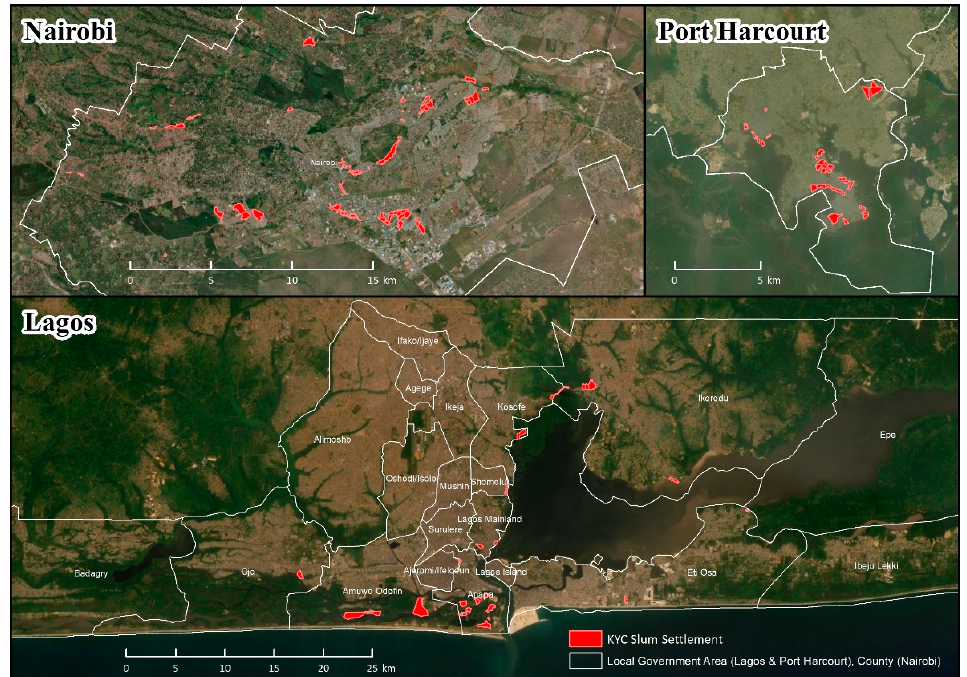
Figure 2. Lagos Nigeria ( n = 32), Port Harcourt Nigeria ( n = 39), and Nairobi Kenya ( n = 63) slum settlements in KYC dataset.